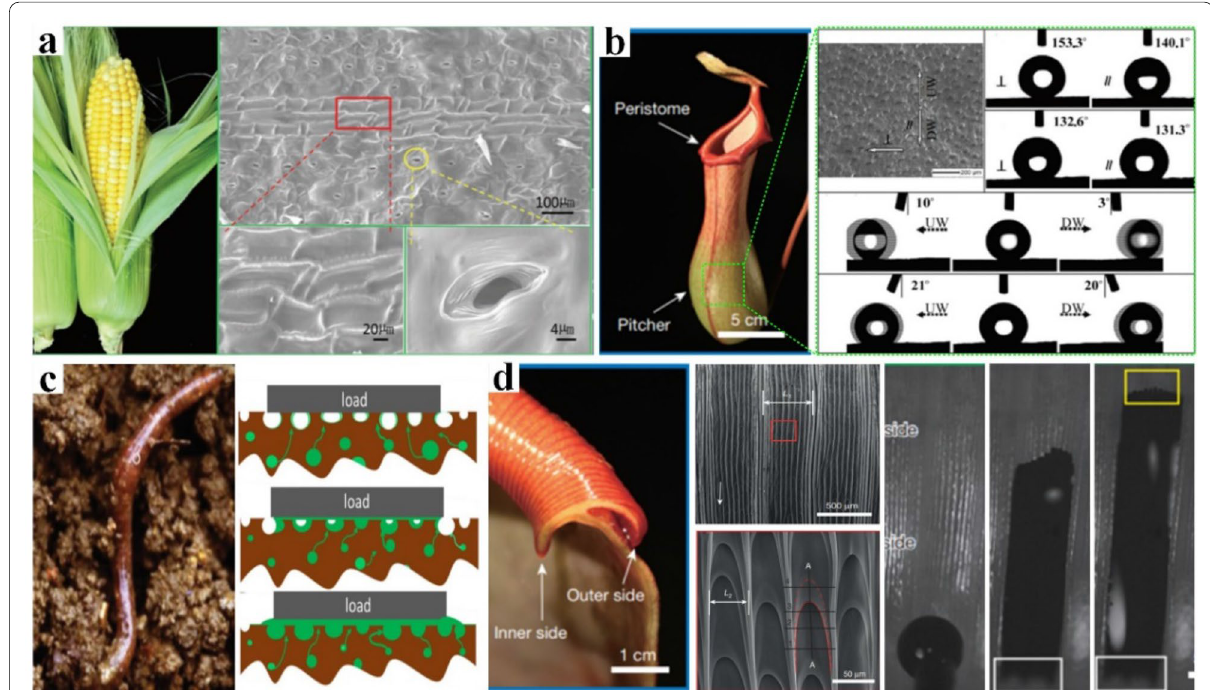
Figure 3 Anti-adhesion and slipping discovered on natural surfaces: ( a ) maize leaf with a grid-like structure, ( b ) superhydrophobic surface of Nepenthes alata , ( c ) earthworm-inspired self-replenishing lubrication surfaces, ( d ) unidirectional liquid spreading on the peristome of Nepenthes